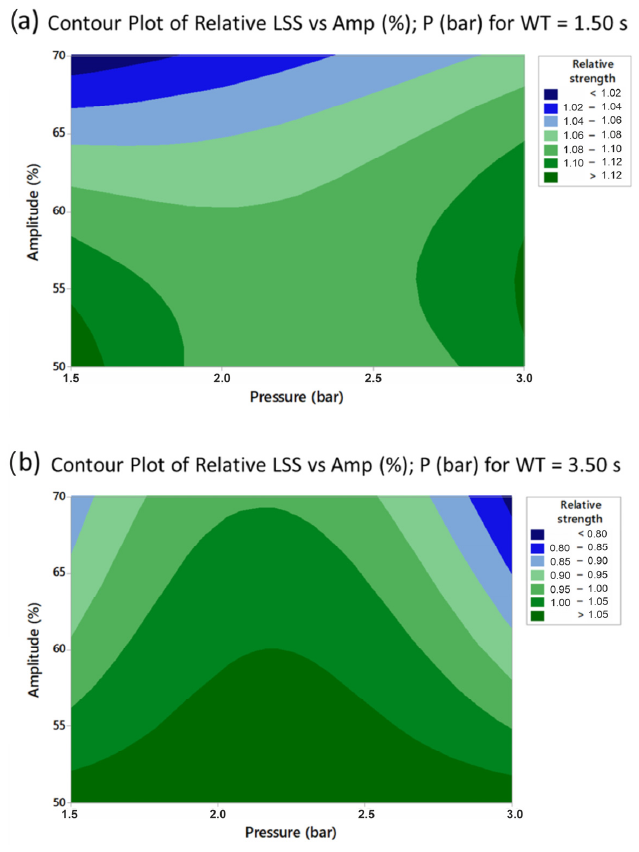
Figure 14. Contour plots of relative average lap shear strength vs. amplitude and pressure at constant welding time: ( a ) 1.5 s; ( b ) 3.5 s.